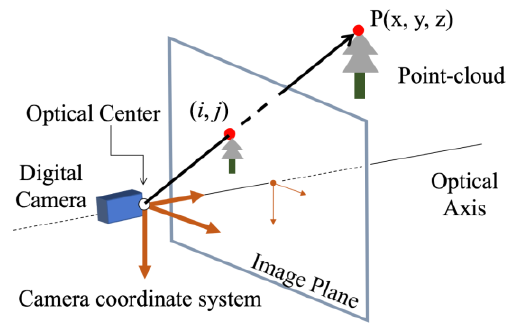
Figure 7. Projection of points onto an image plane